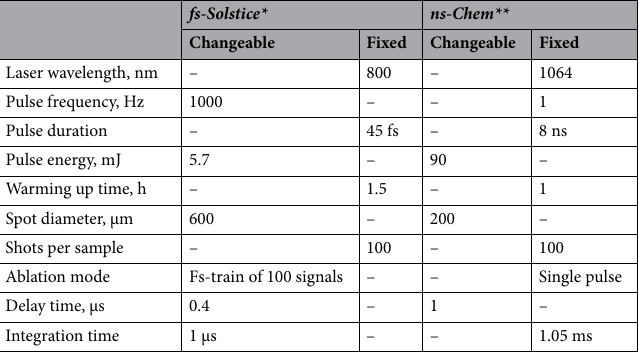
Table 9. Operation parameters of fs-Solstice and ns-Chem systems. *Optimized for best-achieved: SBR, spectral resolution, and no lines saturation/interferences. **Factorial design based on best-tested: signals’ repeatability and quantitative modeling